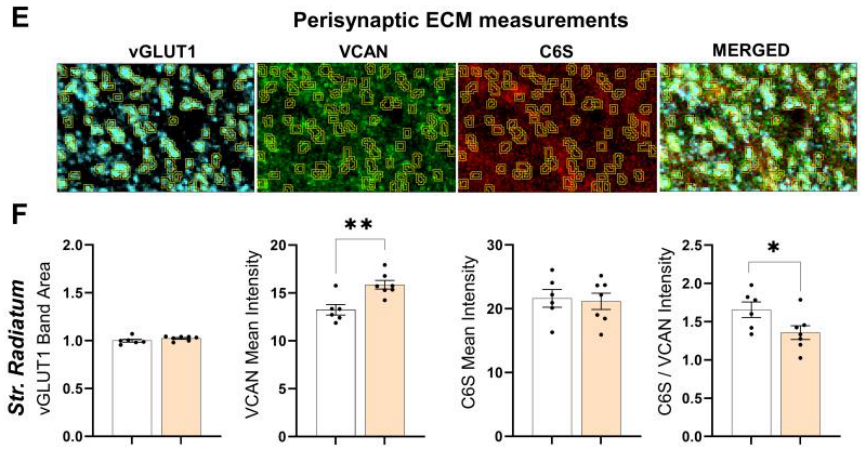
Figure 7. Reduced 6-sulfation of ECM in the hippocampus of 22-24 M-old mice. The functionality of CHST3 enzymes was estimated by using IHC with C6S and VCAN antibodies on hippocampal sections of 2-3 M-old mice and 22-24 M-old mice. Representative images of the method used to quantify the amount of VCAN core proteins associated with 6-sulfated GAGs around: ( A ) PV+ interneurons (perineuronal), ( C ) axon initial segment (periaxonal), and ( E ) excitatory synapses (perisynaptic). Computing a ratio between C6S and VCAN core protein expression levels showed a significant reduction in 6-sulfated ECM at the ( B ) perineuronal, ( D ) periaxonal, and ( F ) perisynaptic sites in 22-24 M-old mice relative to 2-3 M-old mice. Bar graphs show mean ± SEM values; * p < 0.05 and ** p < 0.01 represent significant differences between 2-3 M-old mice ( n = 6) and 22-24 M-old mice ( n = 7).